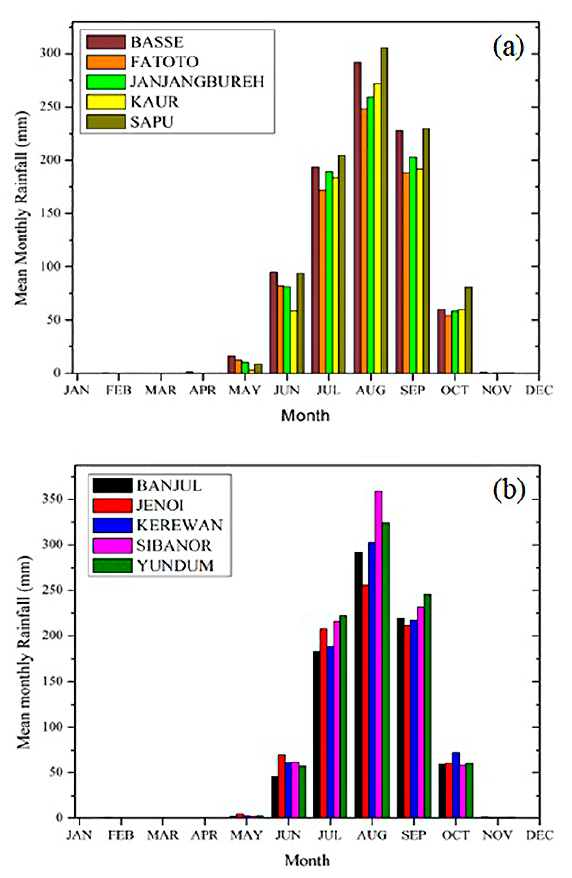
Figure 3. Mean monthly rainfall over the (a) eastern sector, (b) western sector of The Gambia